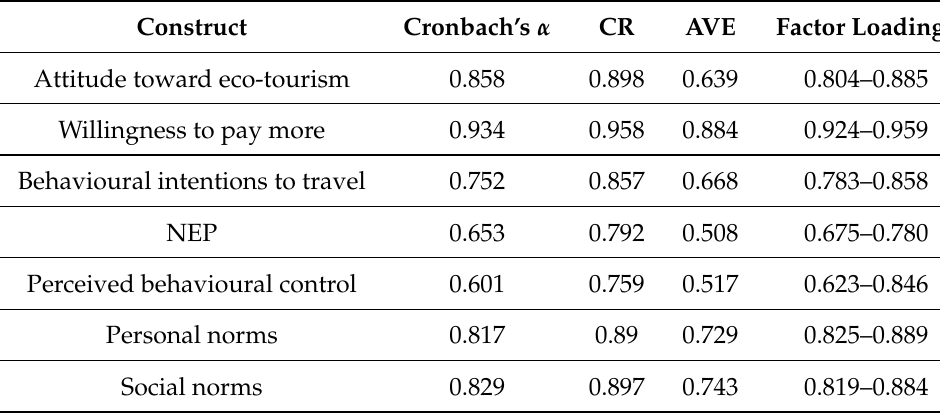
Figure 1. Respondents’ choices of dream destinations and eco-friendly destinations. Table 2. Assessment of construct reliability and